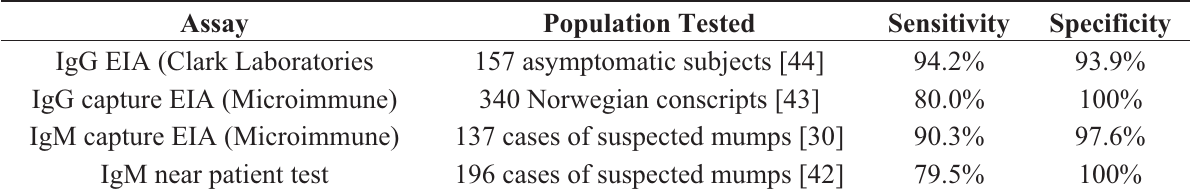
Table 1. Reported performance of mumps oral fluid enzyme immunoassays (EIAs) and near patient